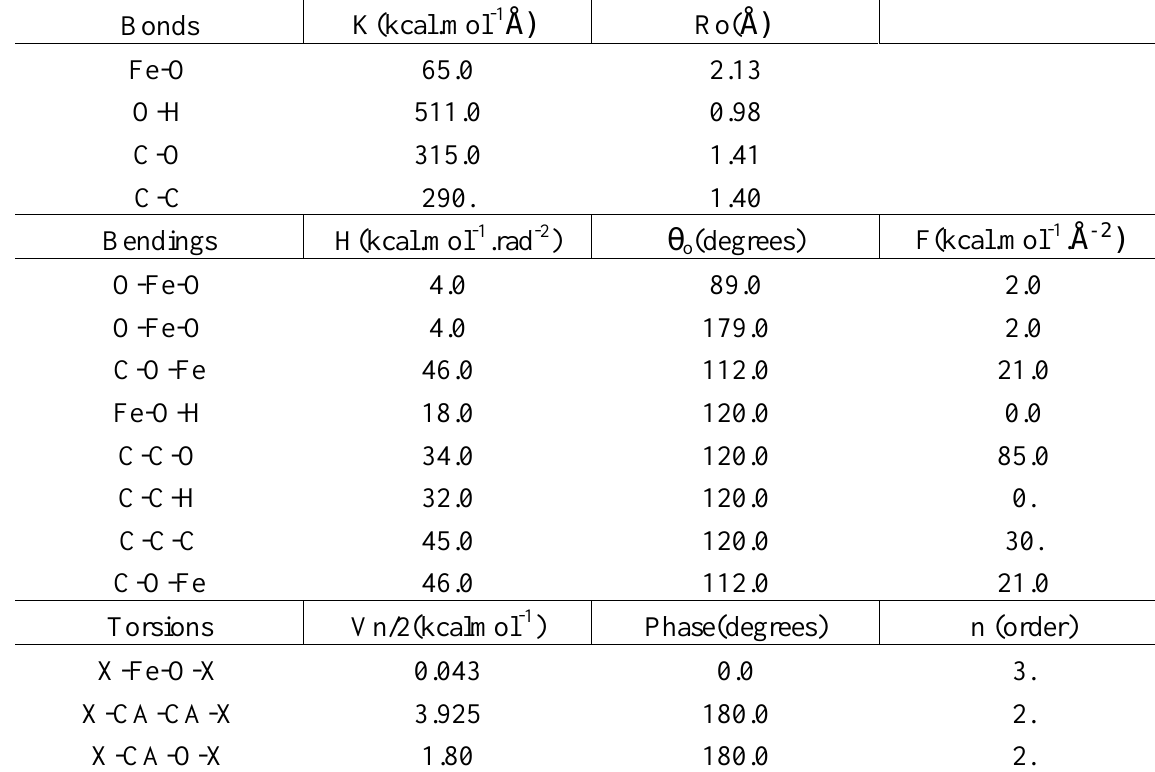
Table 6. Final force constants deduced from SPASIBA empirical calculations carried on the